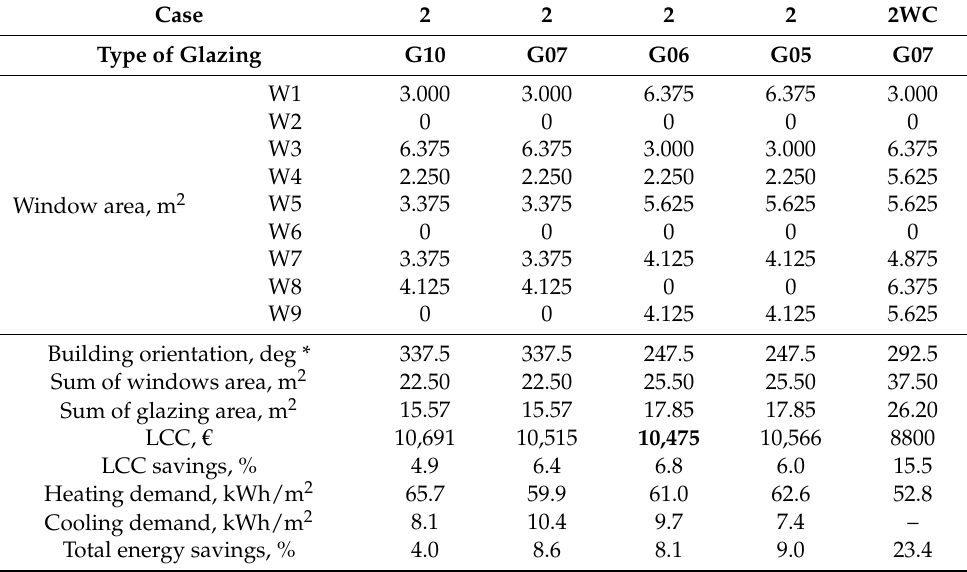
Table 8. Optimal results for case